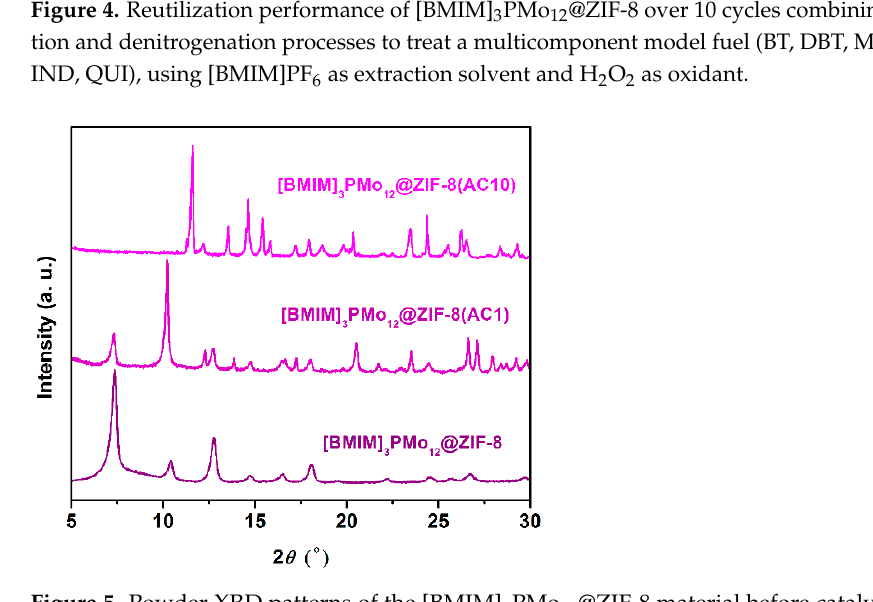
Figure 5. Powder XRD patterns of the [BMIM] 3 PMo 12 @ZIF-8 material before catalytic utilization, isolated after the 1st ([BMIM] 3 PMo 12 @ZIF-8(AC1)) and after the 10th catalytic cycle.